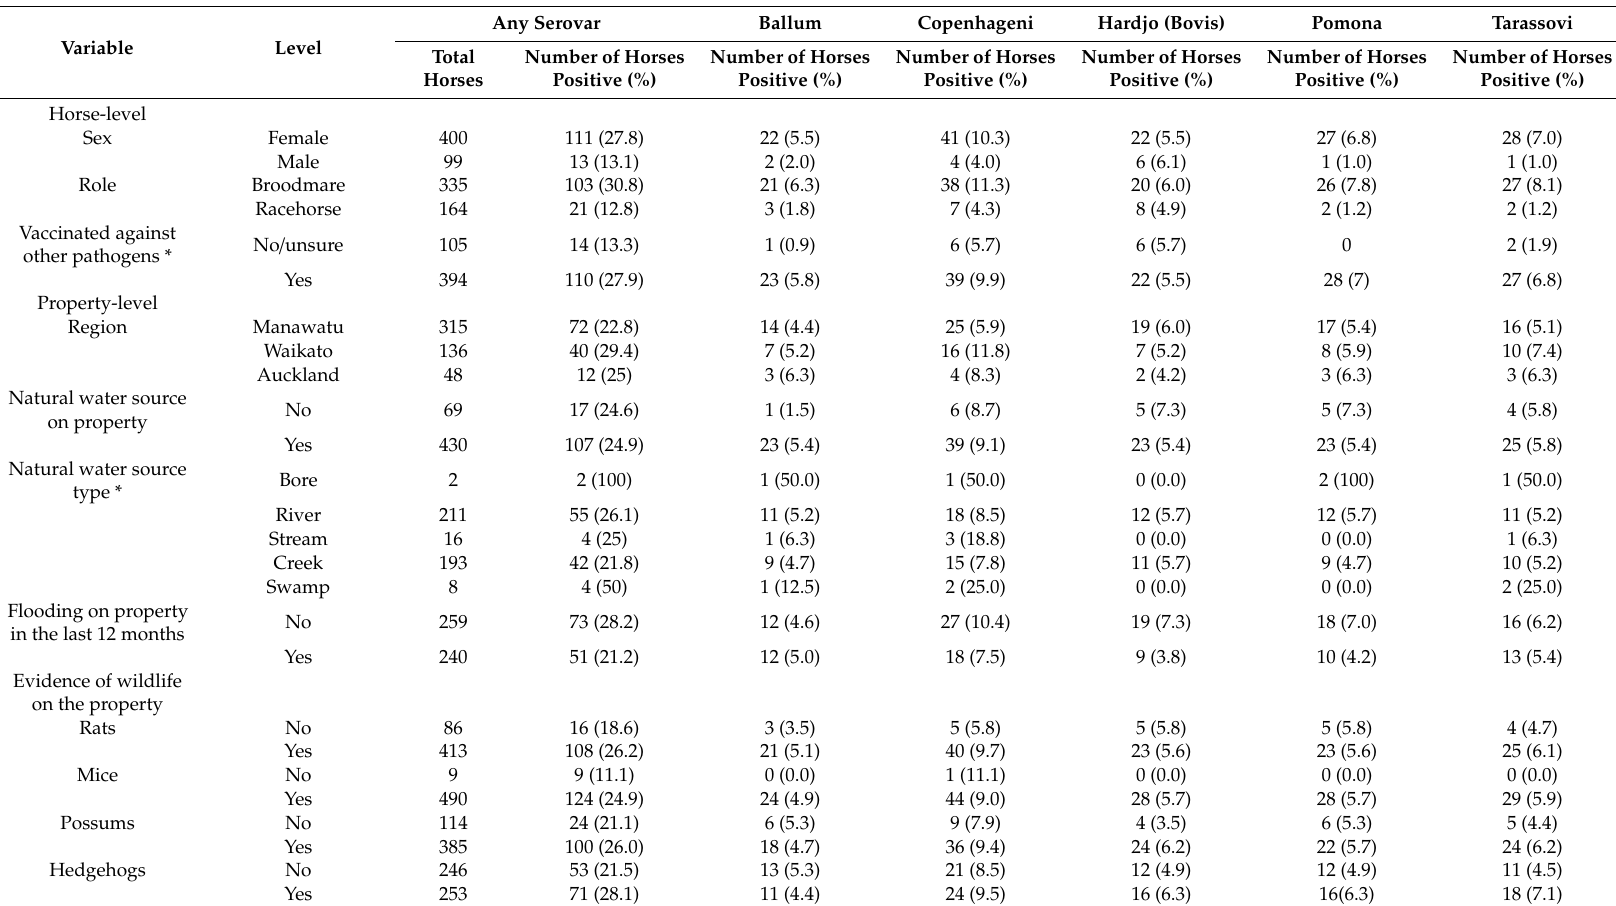
Table 1. The number and percentage of horses positive to any Leptospira serovar (at cut-o ff ≥ 50), and each serovar individually stratified by horse- and property-level variables obtained from a convenience sample of racehorse trainers and stud